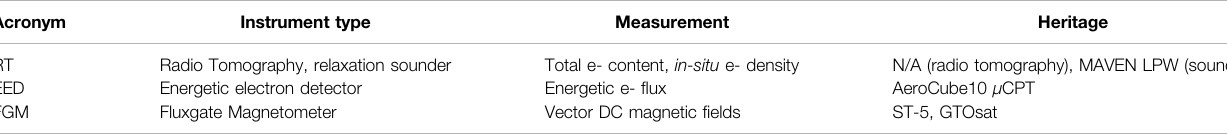
TABLE 1 | RadioSat instruments and heritage.